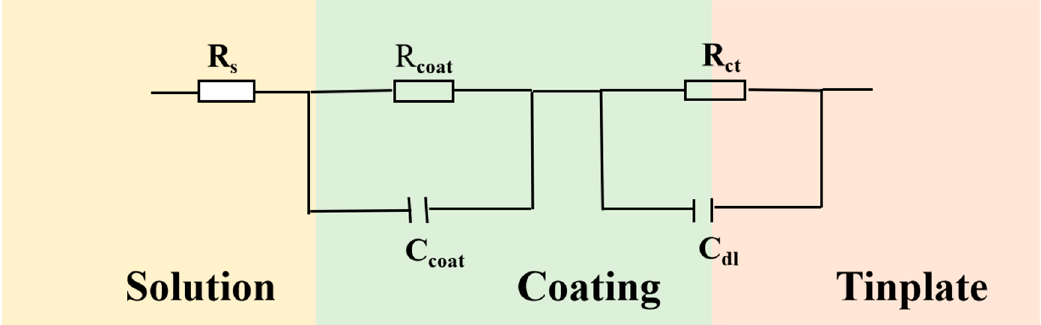
Figure 7. Equivalent circuits of E51 and E-FGO coatings.